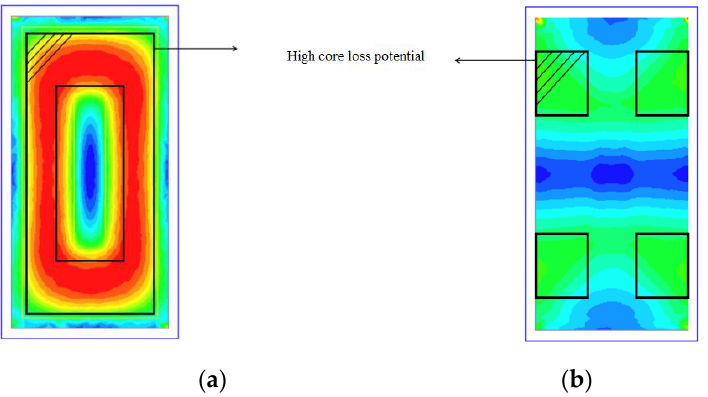
Figure 12. B-field distribution and high core loss potential areas: ( a ) Primary core; ( b ) Secondary core. In order to eliminate the core loss and maintain enough coupling, the ferrites on both sides are optimized and shown in Figure 13. The center and outermost parts are retained in primary side, and the middle ring is discarded because high possibility of core loss is observed. In the ferrite on the secondary side, four parts near the four corners and adjacent to the long side are cut off based on core-less design logic.